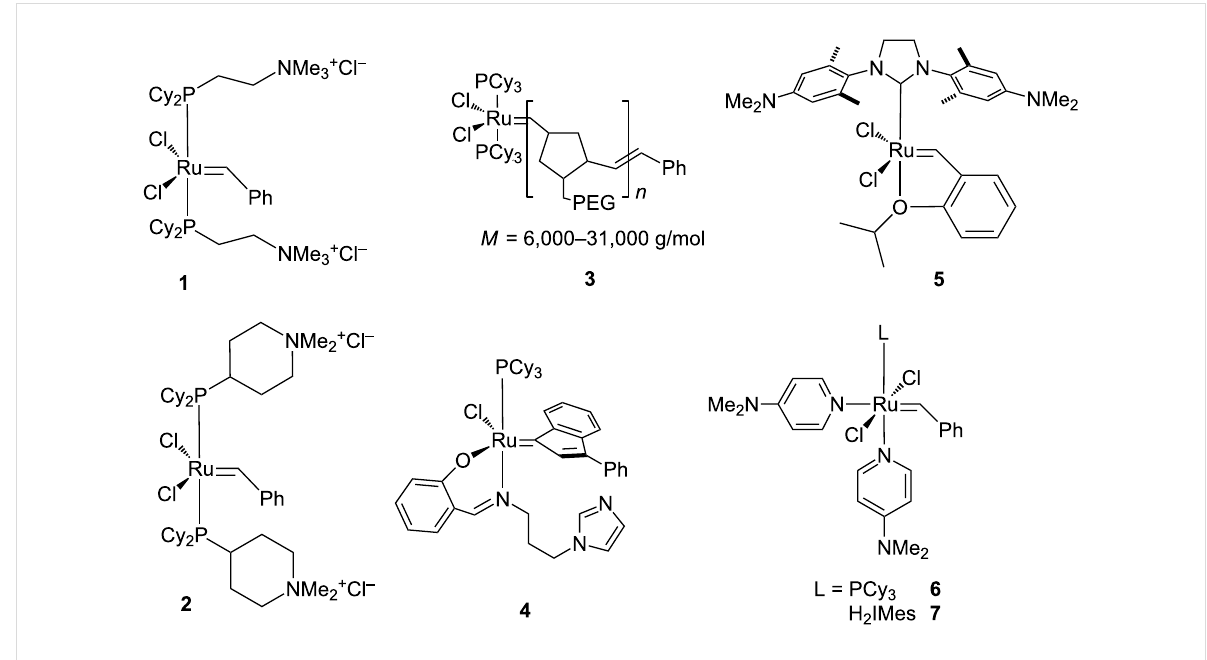
Figure 1: Hydrophilic and/or pH-responsive Ru–alkylidene complexes 1–7 for olefin